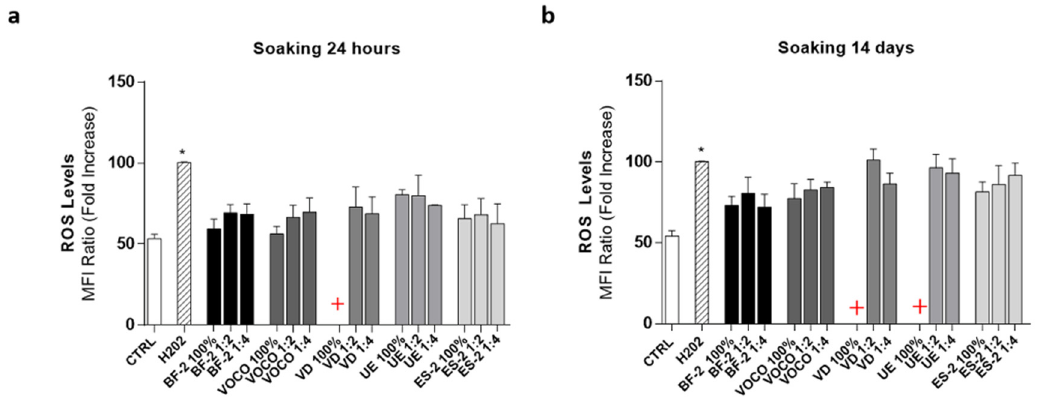
Figure 5. ROS levels. Cytometric analysis of ROS levels in hGDFs following 48 h of treatment with the ( a ) 24-h and ( b ) 14-day CR-derived extracts, undiluted (100%) or not (50% and 25%). Results, expressed as mean ± standard error (SEM) ( n ≥ 3), are shown as the MFI ratio (fold increase) of ROS levels. (* p < 0.05 vs. CTRL). The red crosses indicate values not quantifiable (n.q.) in VD and UE groups due to the high level of cell mortality.